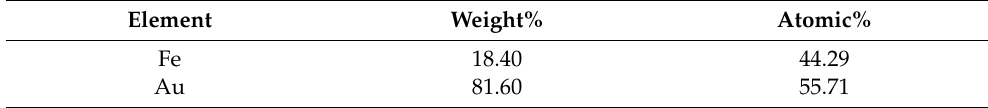
Figure 1. The characterization of FeAu and MMP-1 antibody-conjugated FeAu NPs. ( a ) TEM micro- graph of FeAu NPs, ( b ) TEM micrograph of MMP-1 antibody-conjugated FeAu NPs, ( c ) size distribu- tion of FeAu NPs, ( d ) size distribution of MMP-1 antibody-conjugated FeAu NPs, and ( e ) elemental composition of FeAu NPs analyzed using EDS analysis. Table 1. Elemental distribution analysis using